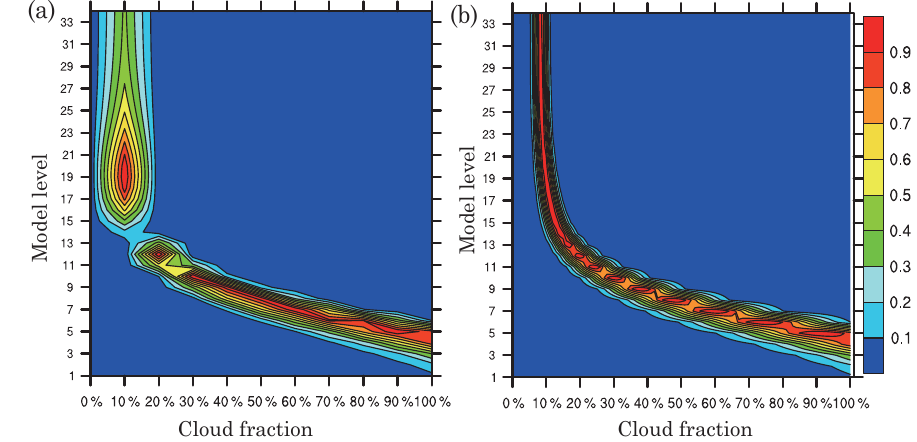
Figure 2. The weights for different particles with specified cloud fractions on the x axis at one chosen model level shown on the y axis from 0 to 100% (a) at the interval of 10% and (b) at the interval of 1%.